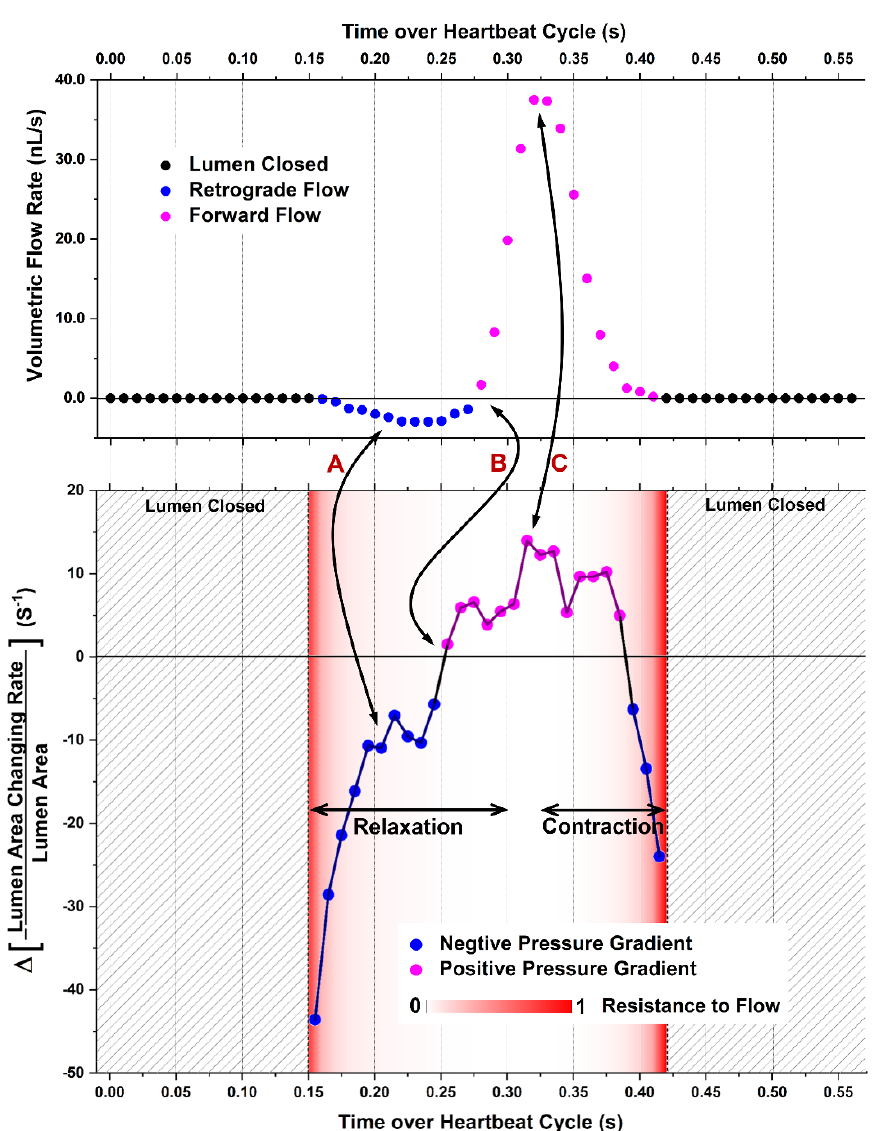
Figure 3. Plot of the temporal relation between the intracardiac pressure gradient, viscous resistance to flow, and volume flow rate for analyzing pumping dynamics in the early embryonic heart. This plot is from the right ventricle of an embryonic day 9.25 mouse embryo. Double arrows A–C indicate the corresponding changes in the flow and the pressure gradient. The pressure gradient is between two locations with a distance of ~60 µm, and the flow is measured around the middle of these two locations. Reproduced from [30].